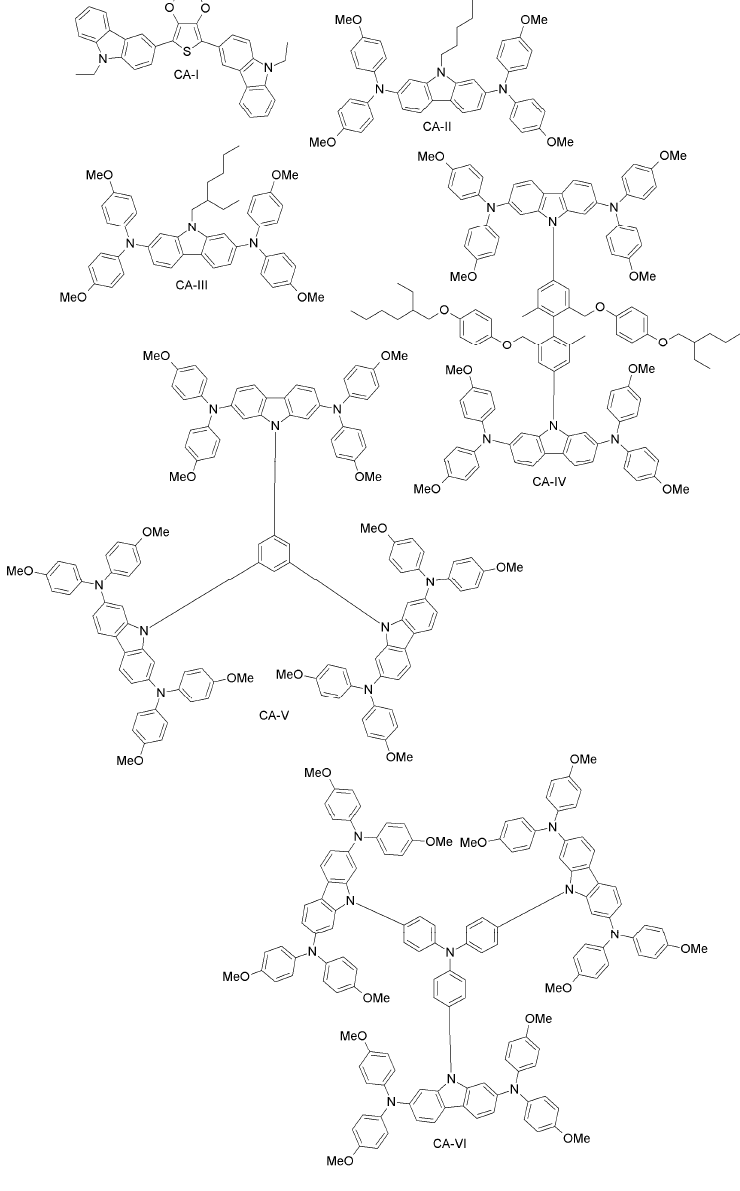
Figure 14. Carbazole-based HTMs (1).